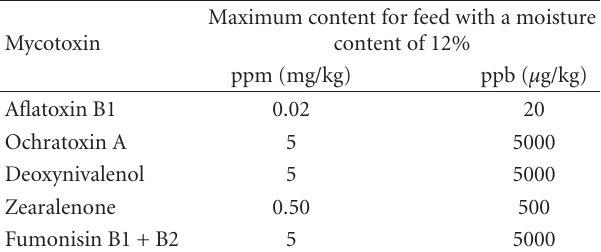
Table 6: Recommended maximum concentration of mycotoxins in rabbit feed